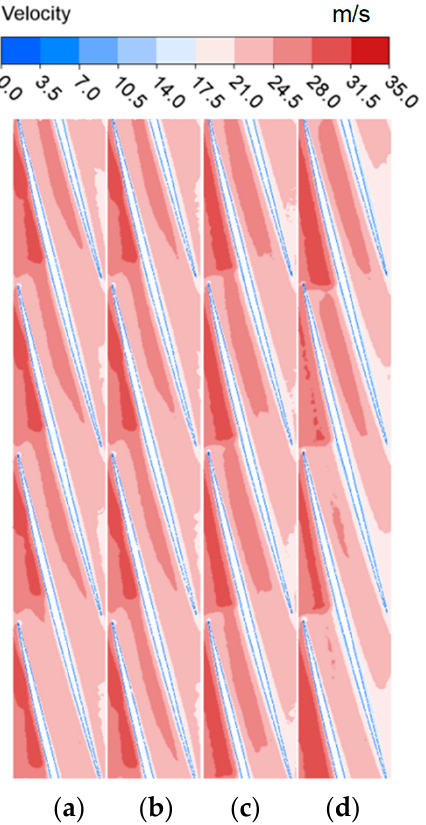
Figure 12. Velocity contours at 0.5 times blade height in impeller passage under critical cavitation condition ( Δ = 3%): ( a ) ν = 24.46 mm 2 /s; ( b ) ν = 48.48 mm 2 /s; ( c ) ν = 60.70 mm 2 /s; ( d ) ν = 120.0 mm 2 /s.